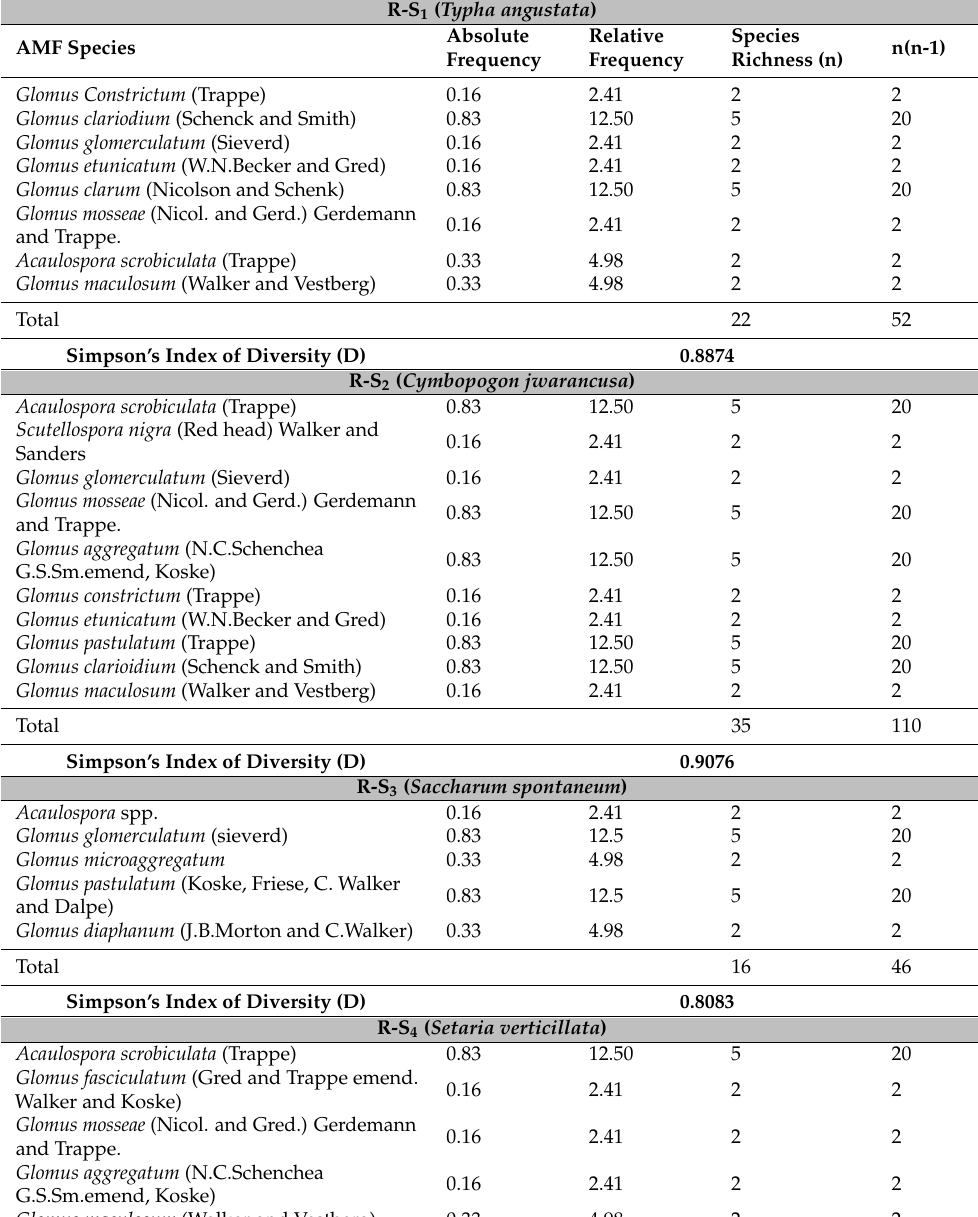
Table 2. Diversity of mycorrhizal spores in rhizospheric soils of different grass species. R-S 1 ( Typha angustata